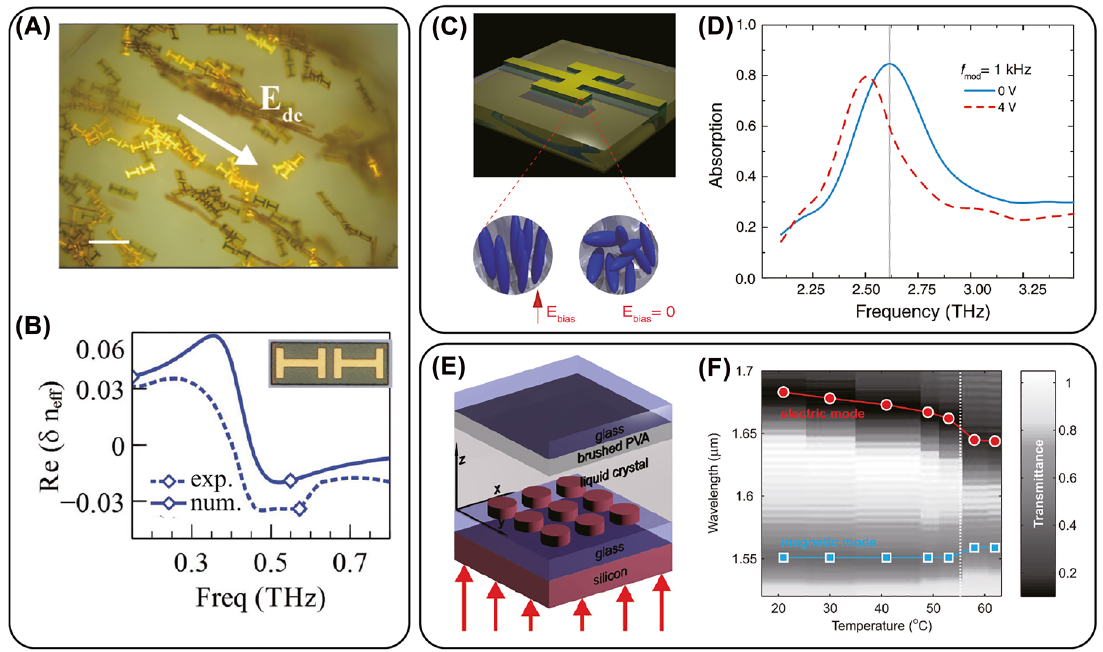
Figure 7: Liquid crystal based tunable metasurfaces. (A) Oriented in one direction of meta-mesogens mades of I-beam resonators under the application of bias electric field. (B) Effective index difference from measurements (dashed line) and simulations (solid line). (A) and (B) reprinted from [185], Copyright 2015 John Wiley & Sons. (C) Illustration of a tunable metasurface absorber with liquid crystal aligned with electric field bias and randomly without bias. (D) Measured absorption spectra for 0 V and 4 V at a modulation frequency of 1 kHz. The dashed line is centered at 2.62 THz. (C) and (D) reprinted from [90], Copyright 2013 American Physical Society. (E) Schematic of a tunable silicon nanodisk metasurface integrated with liquid crystal. (F) Measured transmittance spectra of the silicon nanodisk metasurface. The electric and magnetic resonances are plotted as red-dots and cyan squares, respectively. (E) and (F) reprinted from [199], Copyright 2015 American Chemical Society.